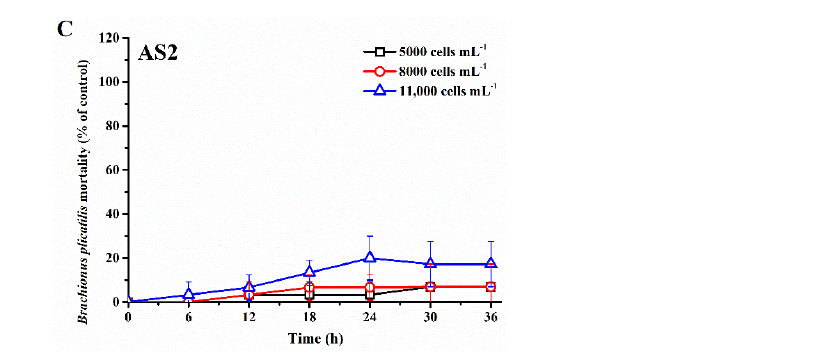
Figure 2. Mortality of Brachionus plicatilis exposed to sonicated cultures of Akashiwo sanguinea . ( A ) JX13, ( B ) JX14, ( C ) AS2. The initial number of B. plicatilis was 10 for each well. Results are expressed in triplicate ± standard deviation (SD).